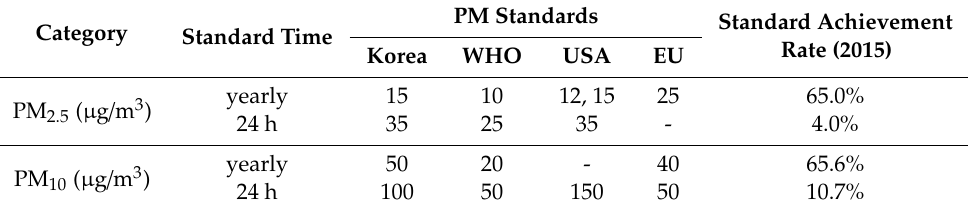
Table 1. Comparison of air quality standards for PM (Source: Ministry of Environment). 124